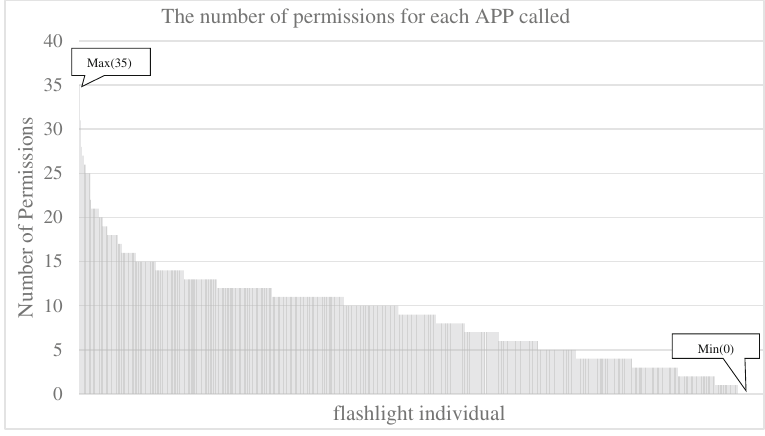
Fig. 5. The number of permissions for each